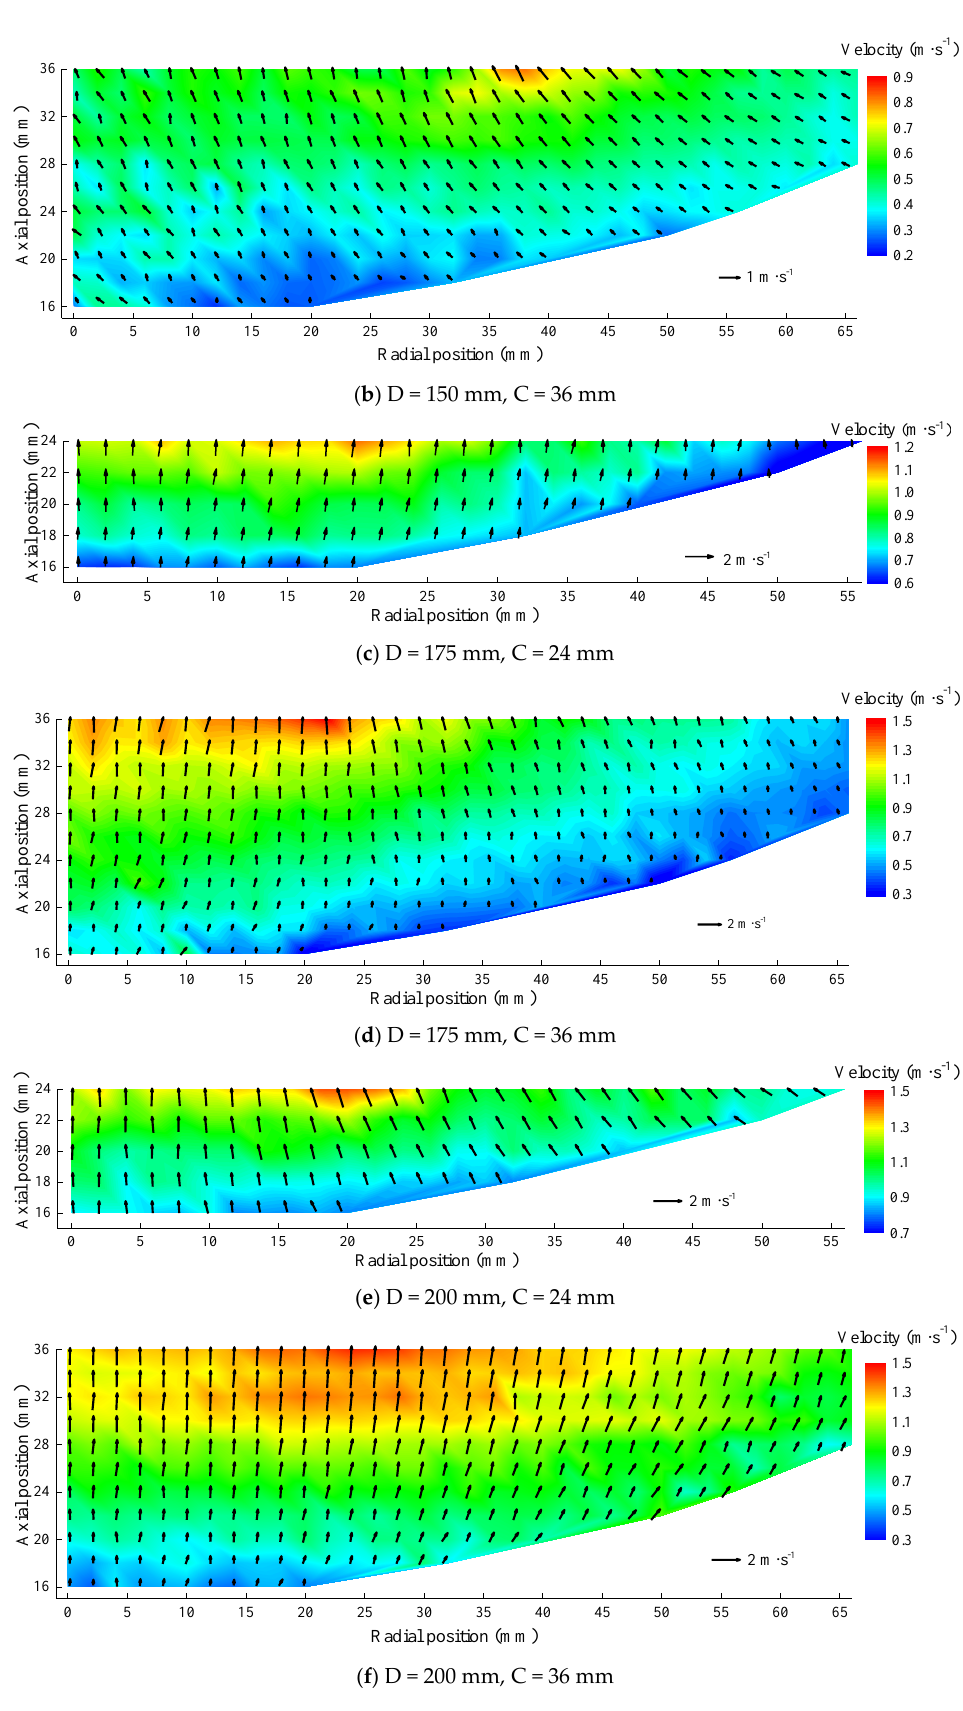
Figure 8. Diagram of the velocity vectors at the bottom of the KYF flotation